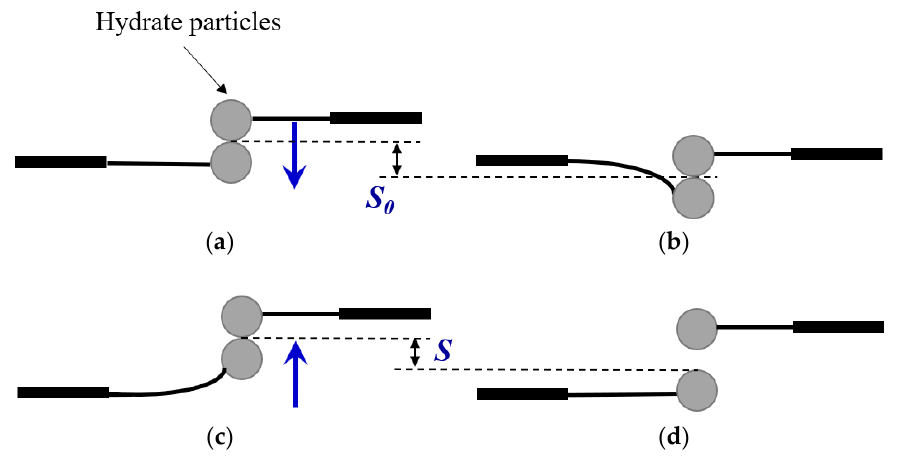
Figure 2. Schematic diagram illustrating the measurement of the cohesion between hydrate particles [16]: ( a ) hydrate particles approach; ( b ) contact and apply a force of 2.2 mN/m; ( c ) hydrate particles begin to separate; ( d ) critical position separation.